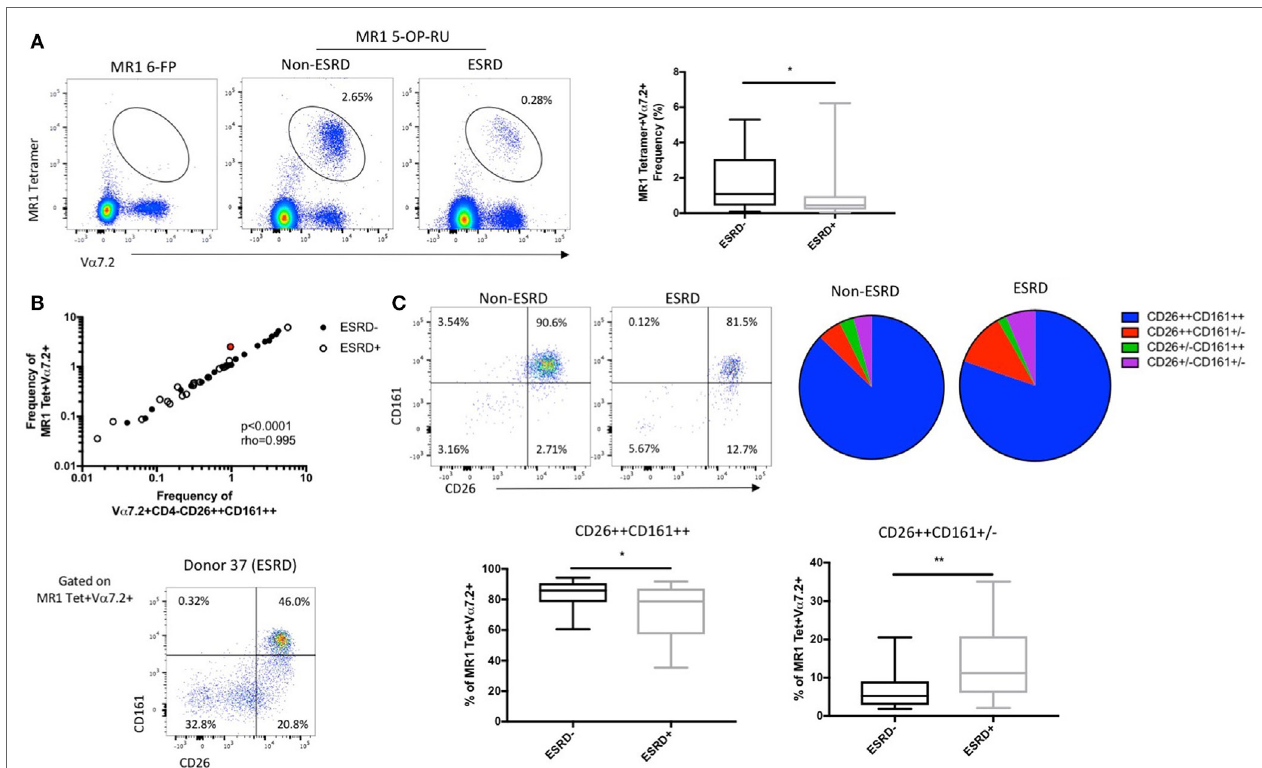
FigUre 2 | Comparison of mucosal-associated invariant T (MAIT) cell identification by surface marker expression and MR1 5-OP-RU tetramer binding ( n = 20 per group). (a) Representative MR1 tetramer staining with the 6-FP (negative control) loaded tetramer or 5-OP-RU loaded tetramer, which binds to MR1-restricted MAIT cells, in a non-end stage renal disease (ESRD) and ESRD participant. The frequency of MR1 tetramer + V α 7.2 + T cells (as a proportion of CD3 + V δ 2 − T cells) is significantly reduced in ESRD participants compared to controls. (B) MAIT cell frequency (as a proportion of CD3 + V δ 2 − cells) as determined by MR1 tetramer binding strongly correlates with the frequency of V α 7.2 + CD4 − CD26 ++ CD161 ++ cells (as a proportion of CD3 +γδ TCR − cells) in both non-ESRD (closed circles) and ESRD participants (open circles). Donor 37, identified in red, exhibited a stronger discrepancy between MR1 tetramer frequency and surface marker frequency than other participants, due to a large proportion of MR1 tetramer + cells with low CD26 and/or CD161 expression. (c) The expression of CD26 and CD161 on MR1 tetramer-staining cells was significantly altered between ESRD and control groups. ESRD participants exhibited a significantly lower proportion of CD26 ++ CD161 ++ cells and an increase in CD26 ++ CD161 ± cells compared to healthy controls. Comparisons performed by Mann–Whitney test, ** p < 0.01, *** p <